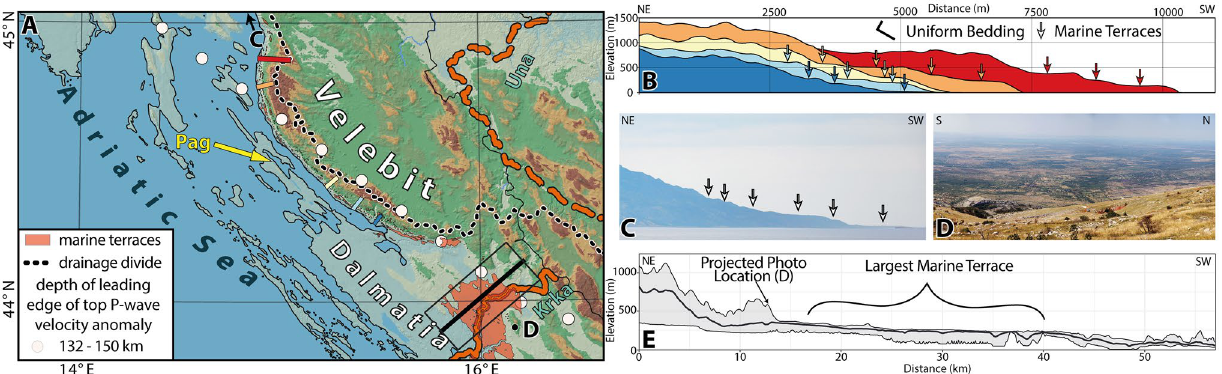
Figure 3. (a) DEM 34 of the Mt. Velebit region, color-coded as in Fig. 1b. Colored lines are section traces along the Mt. Velebit. Black rectangle marks the area of the swath profile across the largest marine terraces (red in Fig. 1b). (b) Topographic profiles show staircase morphology. Terraces are marked by arrows. (c) Field photo of the staircase morphology of the Velebit Mt. (d) Field photo of the largest marine terrace around the Krka River. (e) Swath profile showing lateral extent of the largest preserved marine terrace.